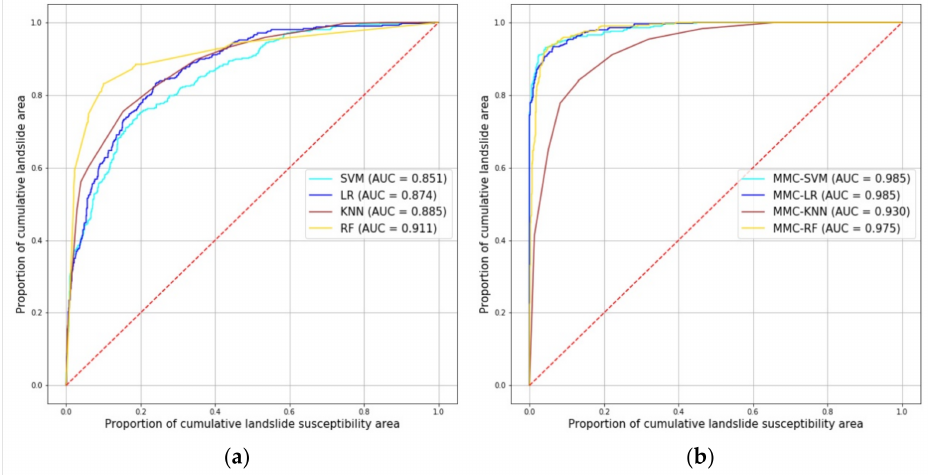
Figure 13. ROC curves of different LSM models: ( a ) without consideration of data modality, and ( b ) with the consideration of data modality.